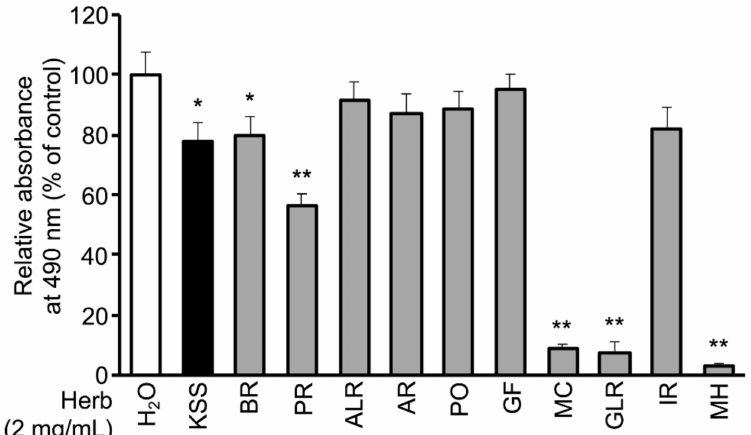
Figure 3. Bupleuri Radix (BR), Paeoniae Radix (PR), Moutan Cortex (MC), Glycyrrhizae Radix (GLR), and Menthae Herb (MH) in KSS reduce lipid accumulation. During di ff erentiation induction by the DMI method, KSS or the 10 constituent herbs (2 mg / mL) were administered and cultured for 8 days. As in Figure 1, the amount of lipid accumulation was measured and is shown as relative absorbance. Data are shown as the mean ± standard deviation ( n = 3). * p < 0.05 and ** p < 0.01 vs. H 2